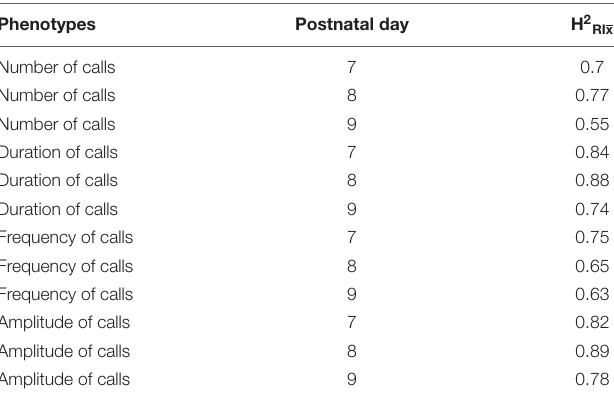
TABLE 5 | H 2 RIx (heritability accounting for repeated sampling of the same genome) estimates for quantitative ultrasonic vocalization traits in the BXD family, measured on postnatal days 7, 8, and